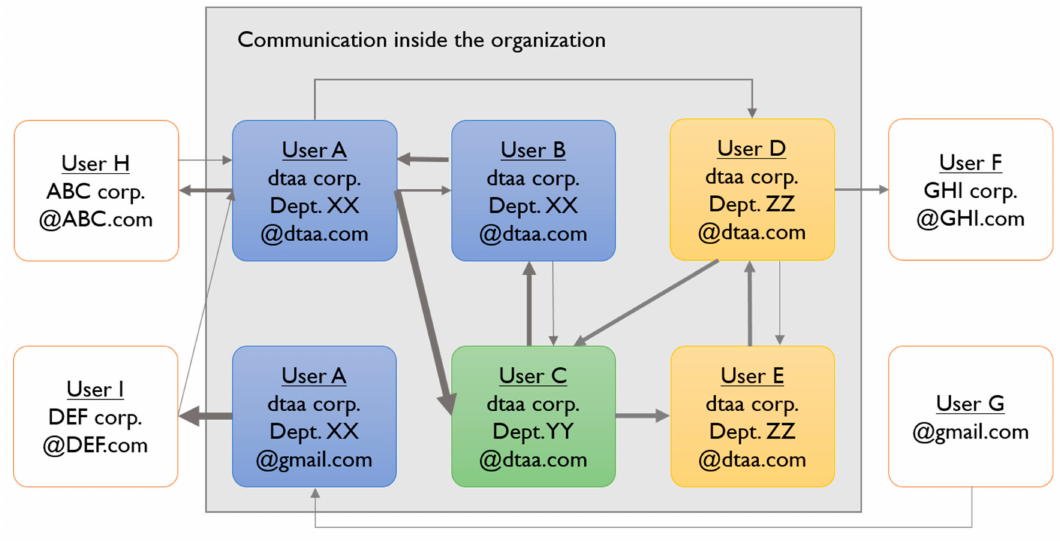
Figure 2. Example of email communication